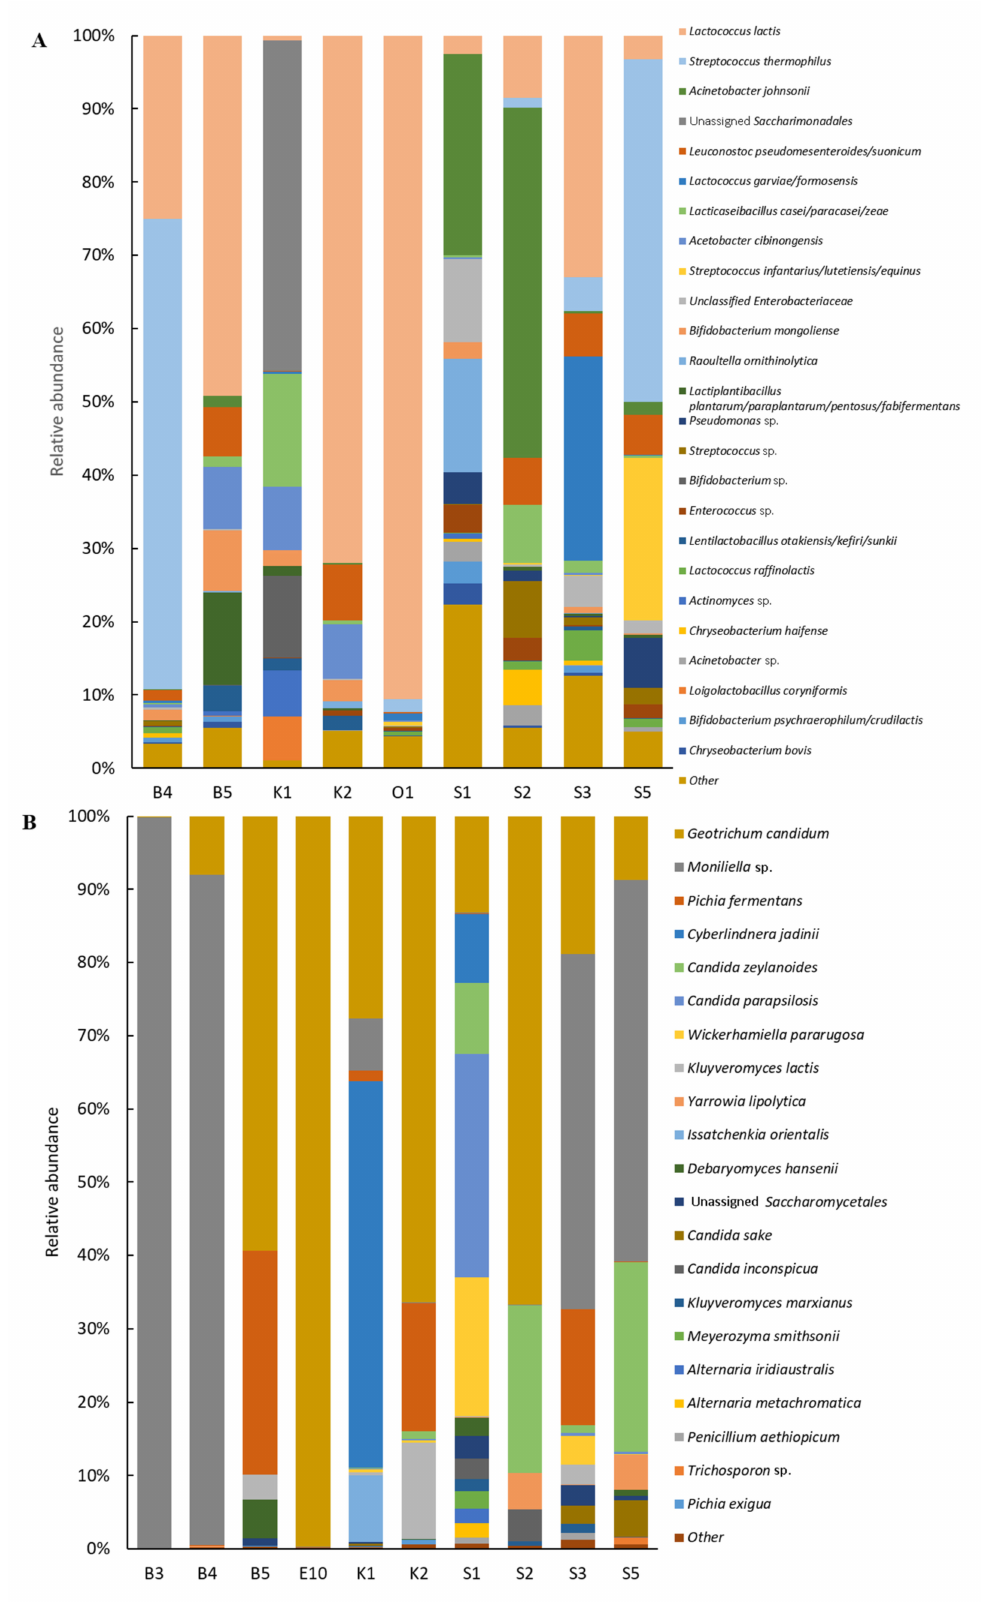
Figure 3. Bacterial ( A ) and fungal ( B ) diversity in Smen samples from different Algerian households determined by a metagenetic